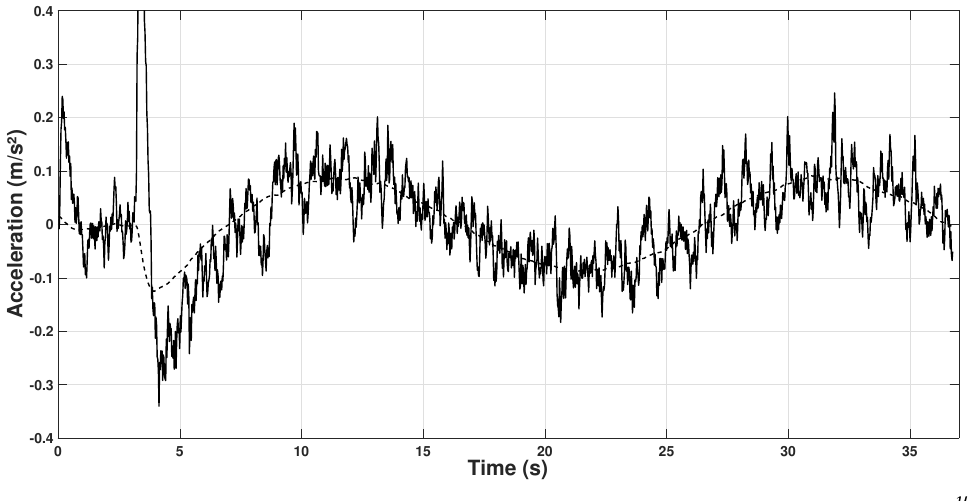
Figure 4. Relation between accelerometer and µ on the X b axis. a b x (continuous line), − (dashed